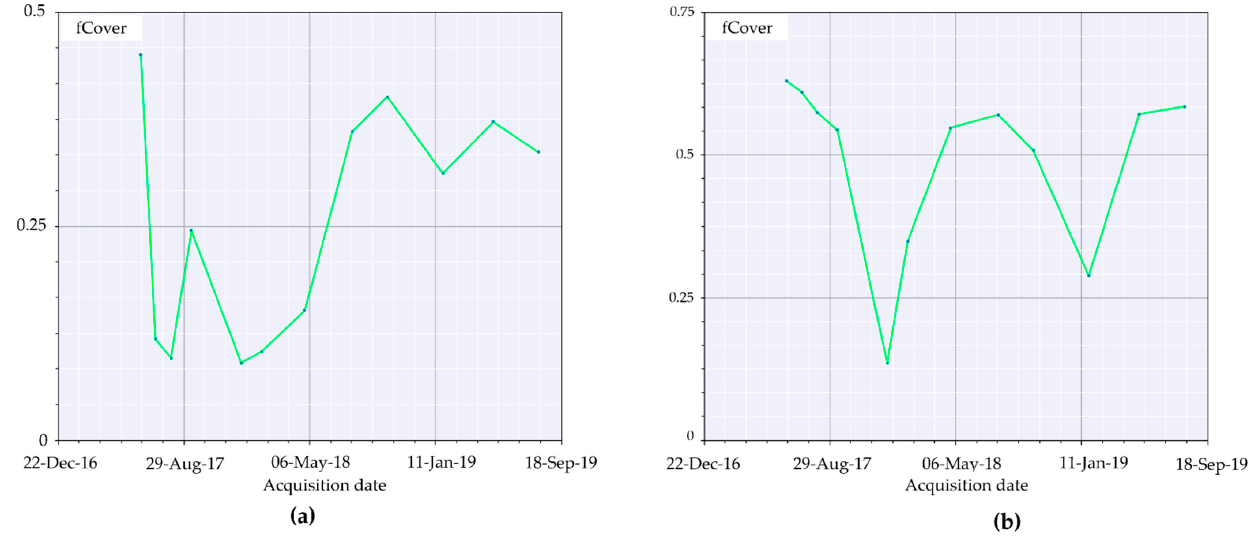
Figure 12. fCover index timeseries computed for: ( a ) the burned area (medium severity); ( b ) unburned area.